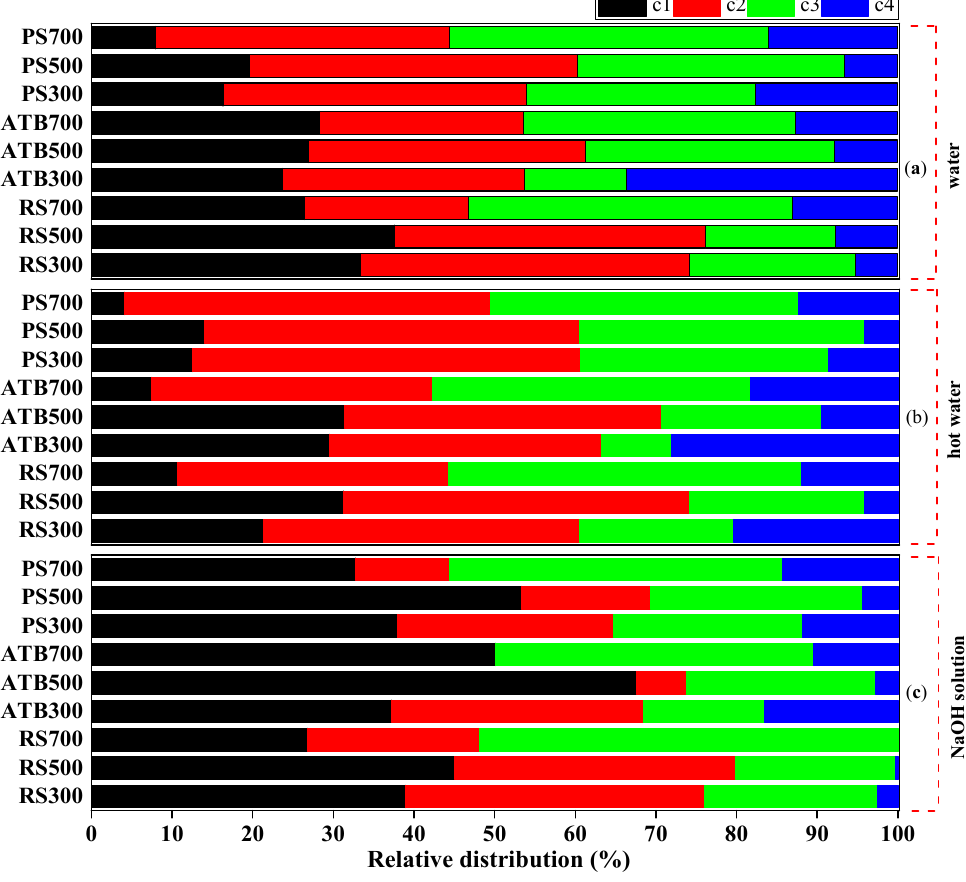
Figure 3. The relative distribution of EEM-PARAFAC analysis components in water ( a ), hot water ( b ) and NaOH solution ( c